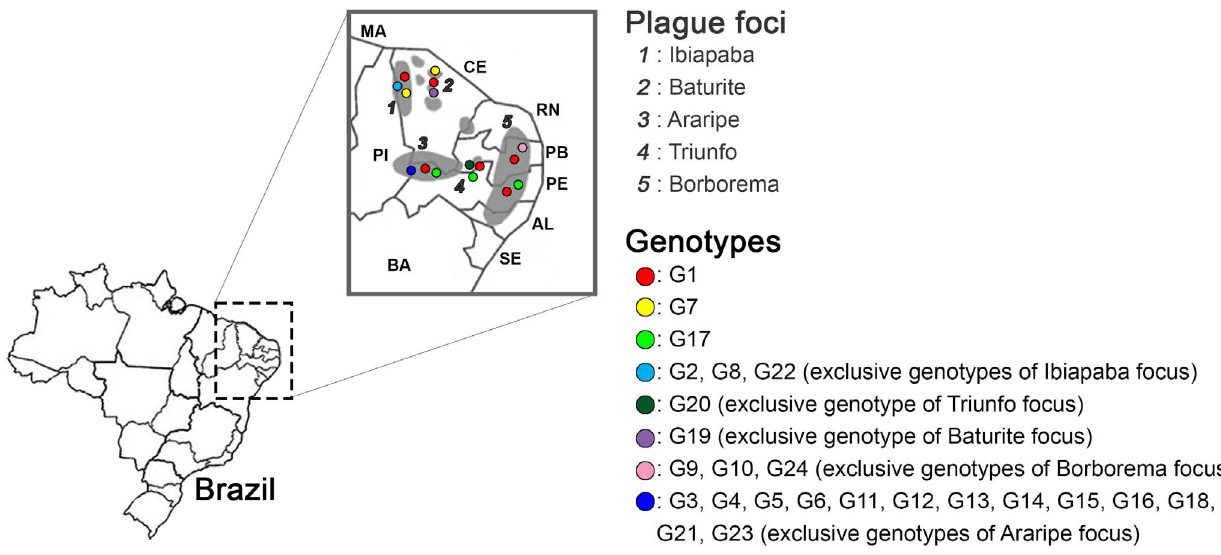
Figure 3. Genotype distribution and natural plague foci on the map of Brazil. Color circles are the 24 exclusives genotypes and letters are the plague foci from Brazil.